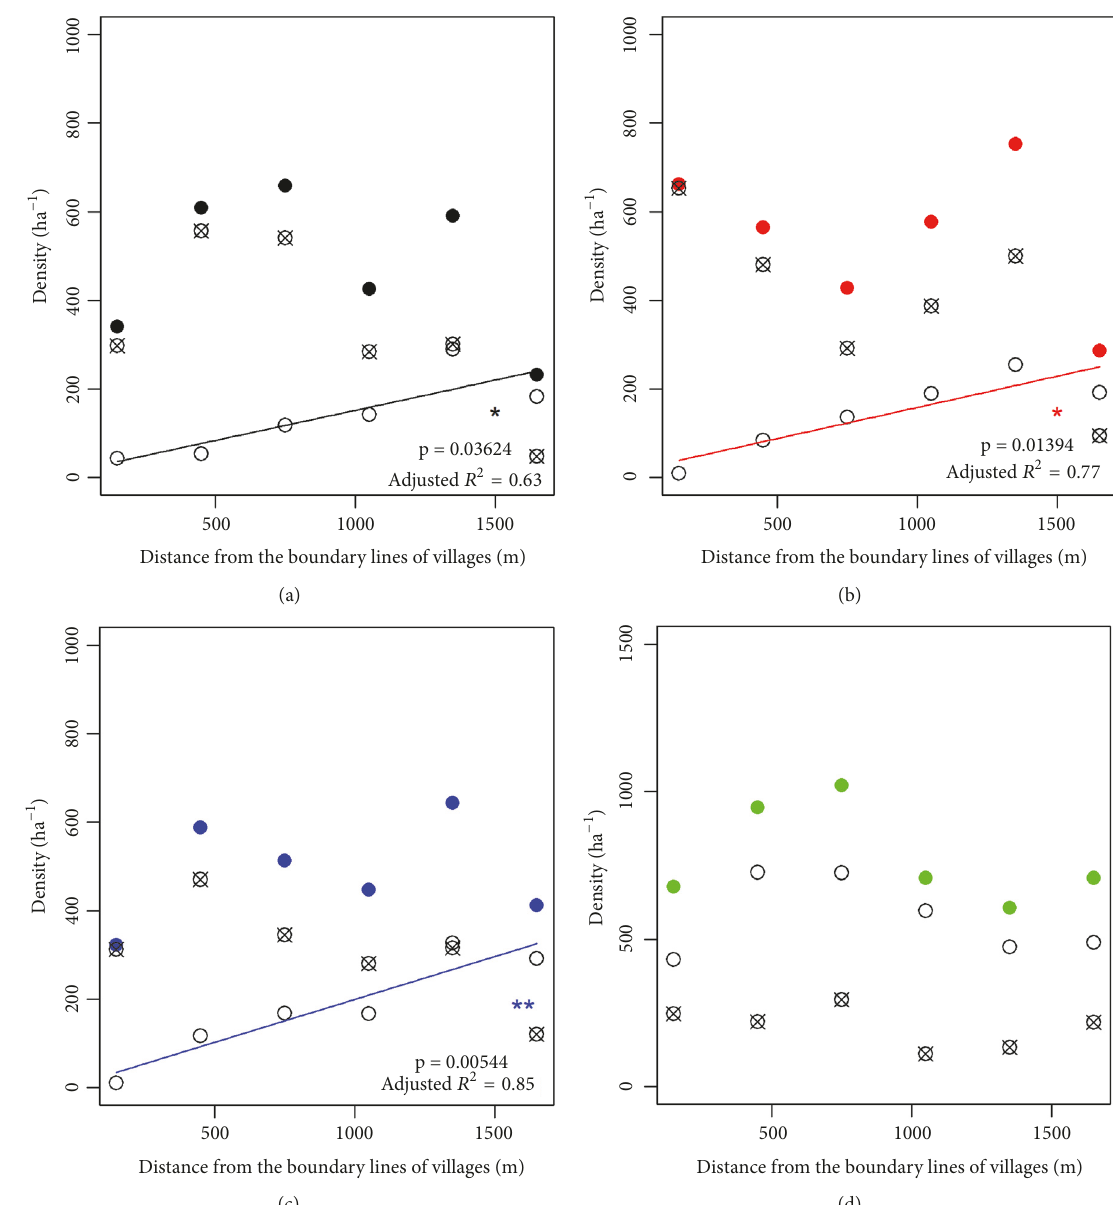
Figure 3: Density (stems ha −1 ) of woody plant species as a function of distance from the village boundaries. In the figure, solid circles, hollow circles, and circles with crosses denote density of all woody species, density of species other than Shorea robusta, and density of S. robusta, respectively. For the density of stems other than S. robusta, the linear trend was significant for (a) Janajagaran BZCF (p < 0.05), (b) Musharni Mai BZCF (p < 0.05), and (c) Radha Krishna BZCF (p < 0.01), but the trend was nonsignificant for (d) Parsa Wildlife Reserve (p >